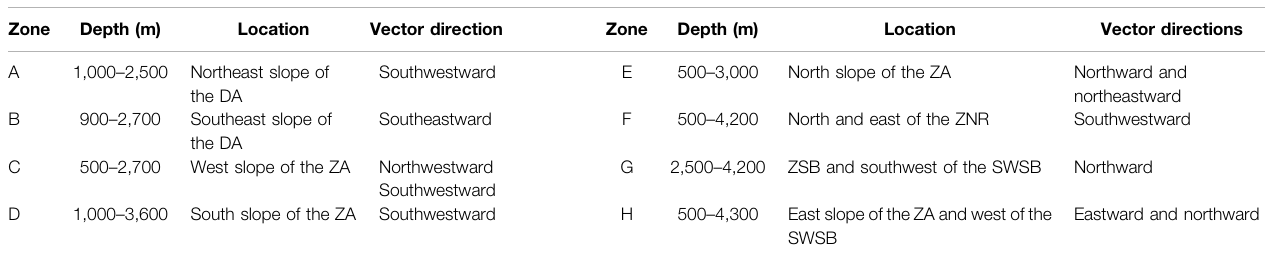
TABLE 1 | Classi fi cation and characteristics of sediment transport